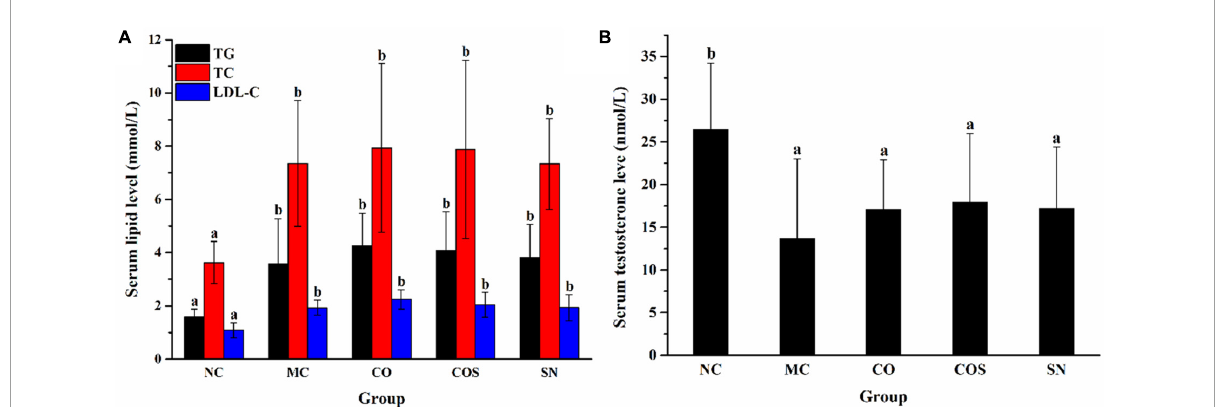
FIGURE1 Serum lipid (A) and testosterone (B) levels of rats at the 30th day in hyperlipidemia-induced reproductive damage modeling. TG, triglyceride; TC, total cholesterol; LDL-C, low-density lipoprotein cholesterol; NC, normal control; MC, model control; CO, Camellia oil; COS, Camellia oil + squalene; SN, sildenafil. Different letters represent significant differences ( p < 0.05).